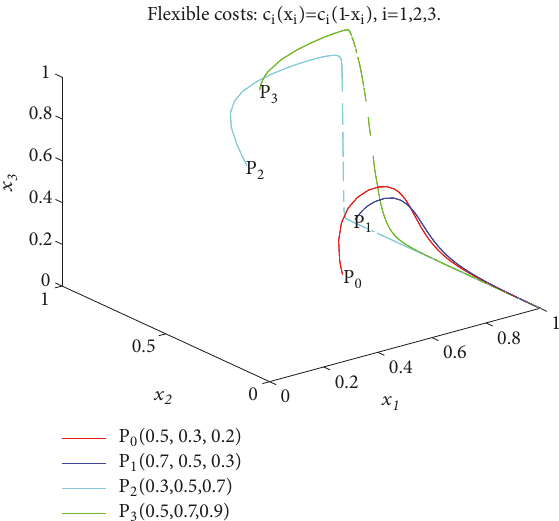
Figure 5: Phase diagram of the tripartite game system with incentive